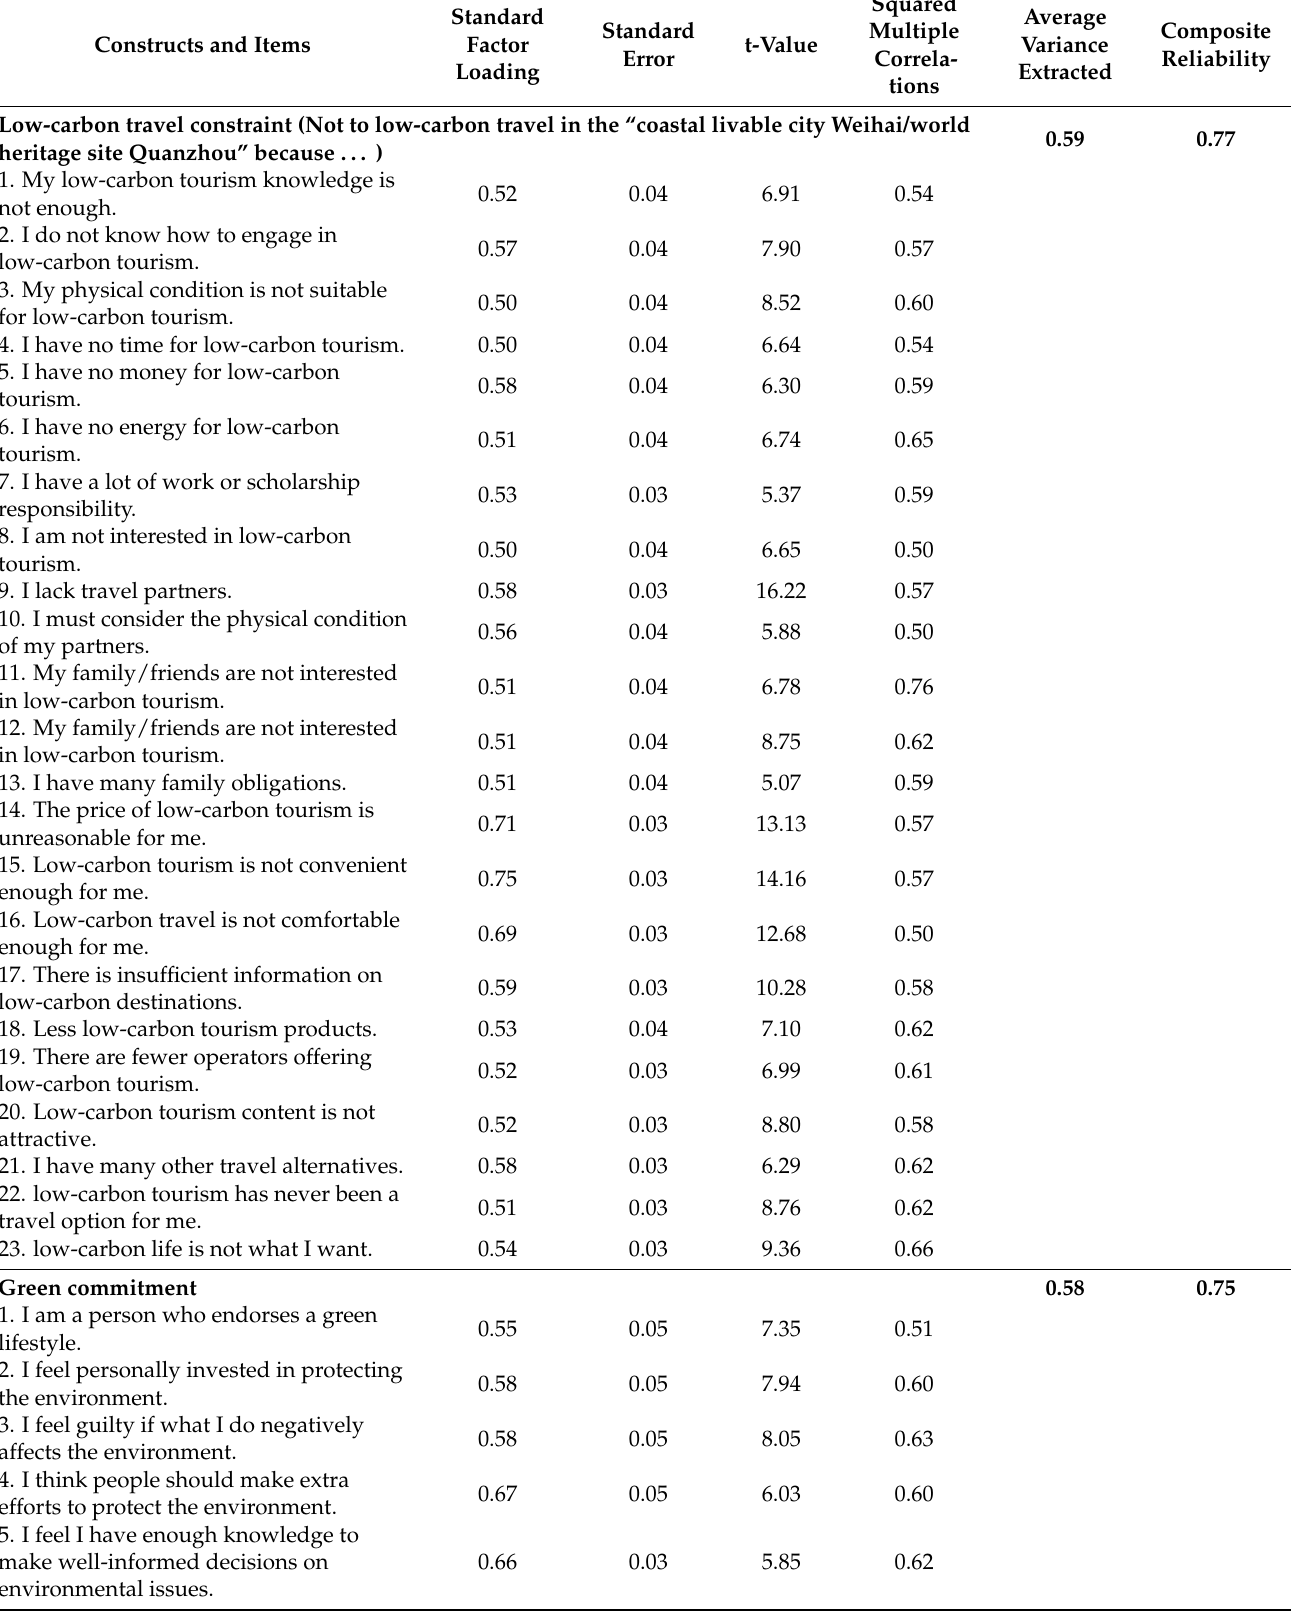
Constructs and Items